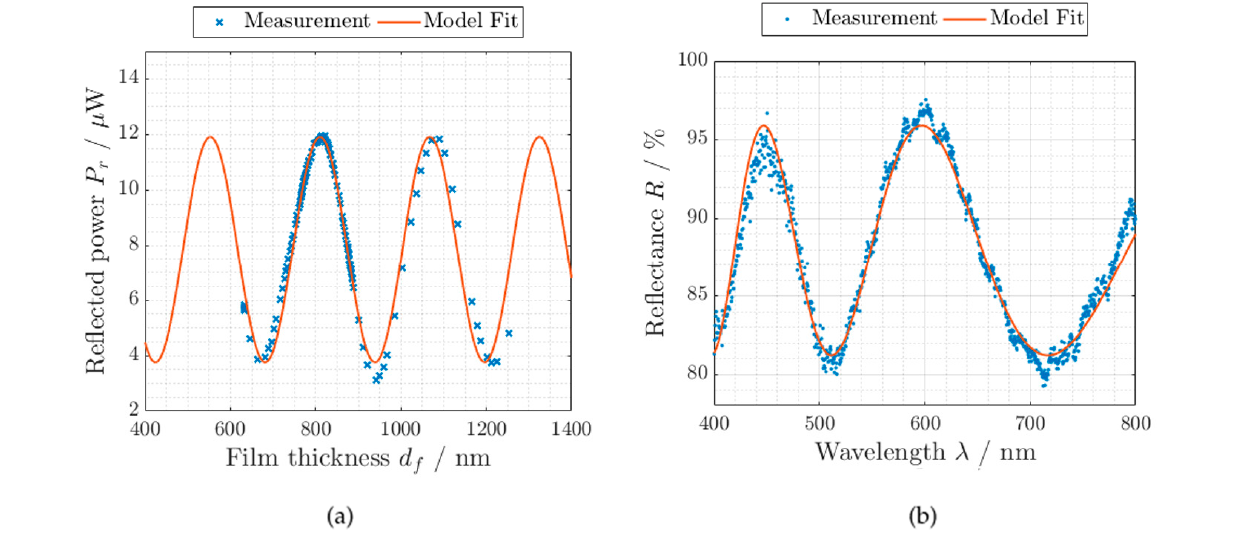
Figure 2. Measurements with corresponding model fit for ( a ) the laser interference setup for a wavelength of 635 nm at an incident angle of 60.5°, which shows the reflected power over the thin- film thickness derived by spectral reflectance measurements like the one shown in ( b ) for a certain thickness value at an incident angle of